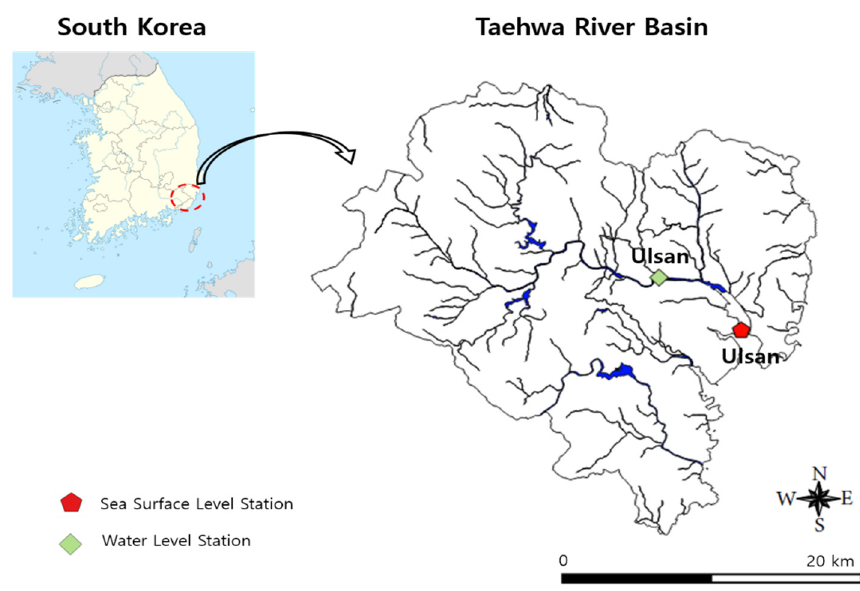
Figure 2. Water level and sea surface level station in Taehwa river basin.